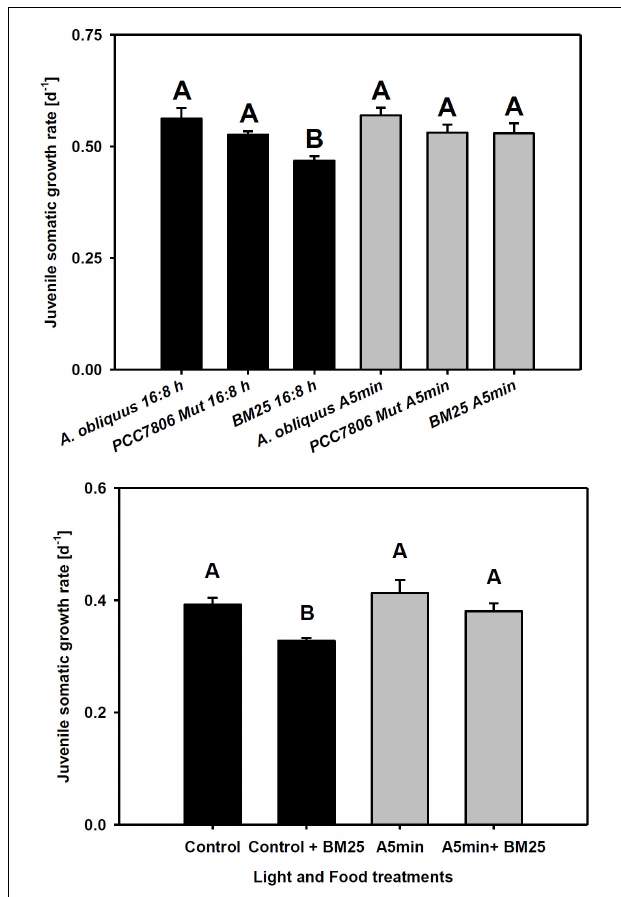
FIGURE 4 | Upper panel: Juvenile somatic growth rates of clone “CH-H-5” fed with 100% A. obliquus , or 80% A. obliquus with 20% of either M. aeruginosa PCC7806 Mut (producing trypsin inhibitors) or Microcystis sp. BM25 (producing chymotrypsin inhibitors). Lower panel: Juvenile somatic growth rates of clone “FR-LR 6-1” fed with 100% A. obliquus , or 80% A. obliquus with 20% of Microcystis sp. BM25 (producing chymotrypsin inhibitors) over 6 days in a day-night cycle of 16:8 h (black columns) and in ALAN (gray columns; A5 min: 5 min light every hour of the night; N = 3, mean + SD). Different letters indicate statistically significant differences between light and food treatments (Tukey’s HSD after two-way ANOVA). Shaded area: night, white area: day.